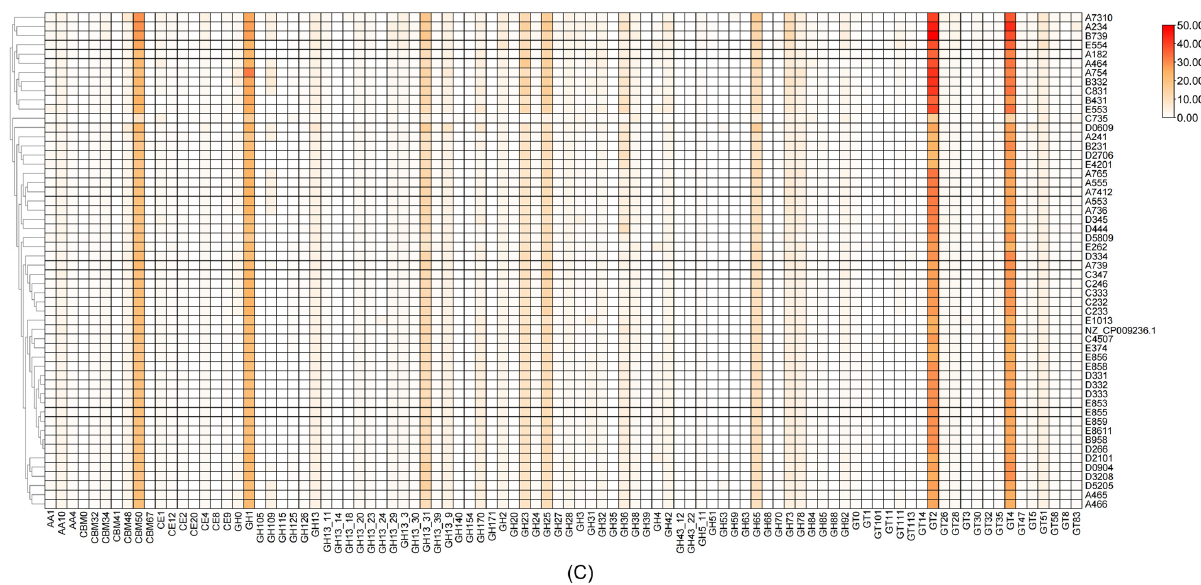
Figure 8. Genotype analysis of carbohydrate utilization in Lactobacillus plantarum . GHs: glycoside hydrolase families; GTs: glycosyltransferase families; CEs: carbohydrate esterase families; CBMs: carbohydrate-binding modules; AAs: auxotrophic active enzyme families. ( A ) Heatmap of gene abundance distribution of five families of carbohydrate-active enzymes in L. plantarum ; ( B ) the number of carbohydrate-active enzymes in different types of fermented foods. Different lowercase letter means the significant difference ( p < 0.05); same lowercase letter means not significant difference ( p > 0.05); ( C ) prediction of carbohydrate-active enzyme of 54 strains of L. plantarum